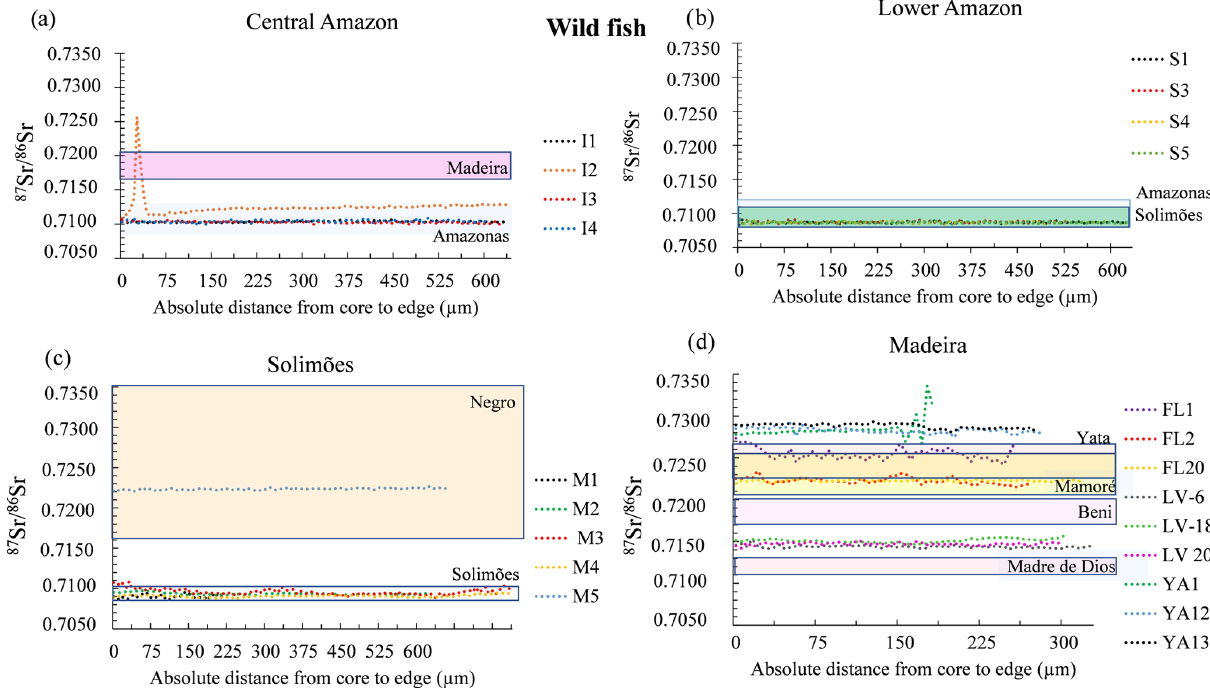
Figure 4. Variation of 87 Sr / 86 Sr values measured by LAfs-MC-ICPMS (laser ablation femtosecond multi-collector inductively coupled plasma mass spectrometry) on wild fish otolith cores – edge transects. Only the final part of the transect (approximately one-third) is represented. Individual fishes were grouped by geographic region: (a) Central Amazon; (b) Madeira; (c) Lower Amazon, and (d) Solimões. The range of 87 Sr / 86 Sr values of river water dissolved matter for each geographic region is indicated by a colored rectangle (based on literature and additional analyses, see Appendix Table